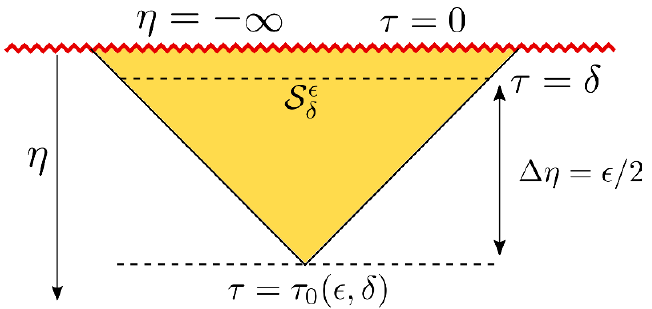
Figure 10 . The regularized terminal S δ ǫ and its past domain of